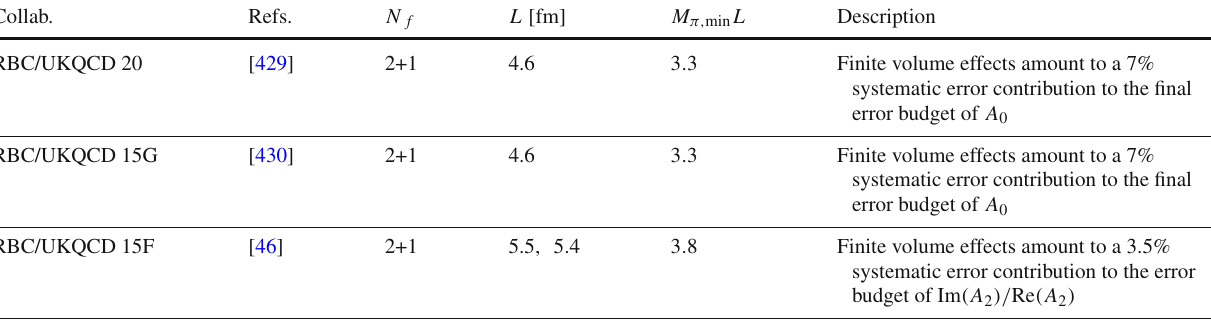
Single pion mass value – close to the physical point – at each of the two values of the lattice spacing